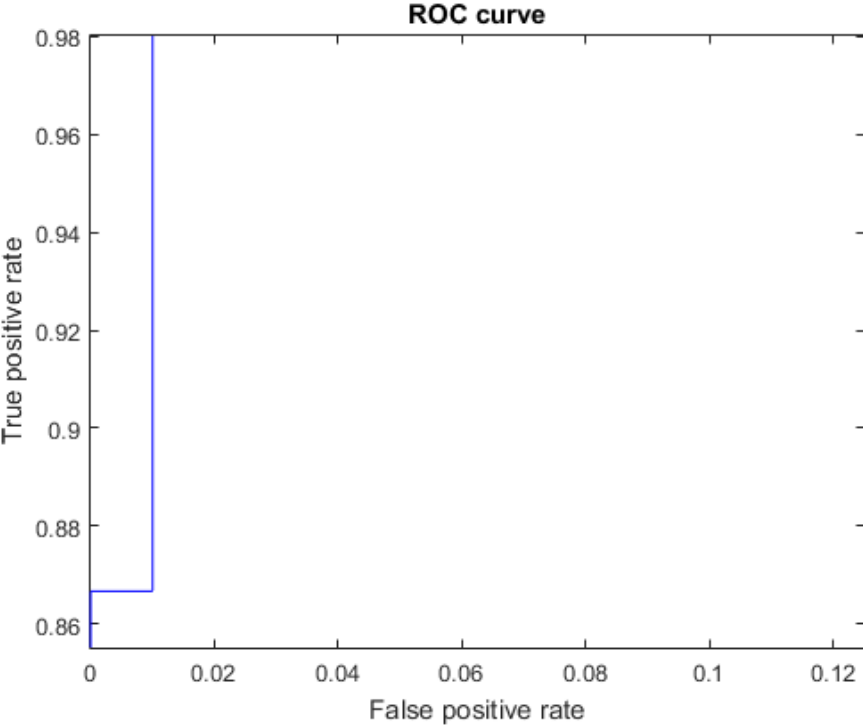
Figure 15. ROC curve for the letter P using Cartesian features, AUC = 0.9987.